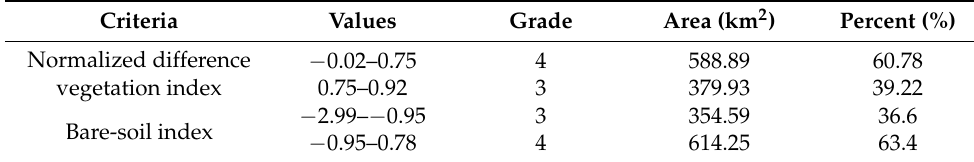
Table 9. Assessment of vegetation conditions.